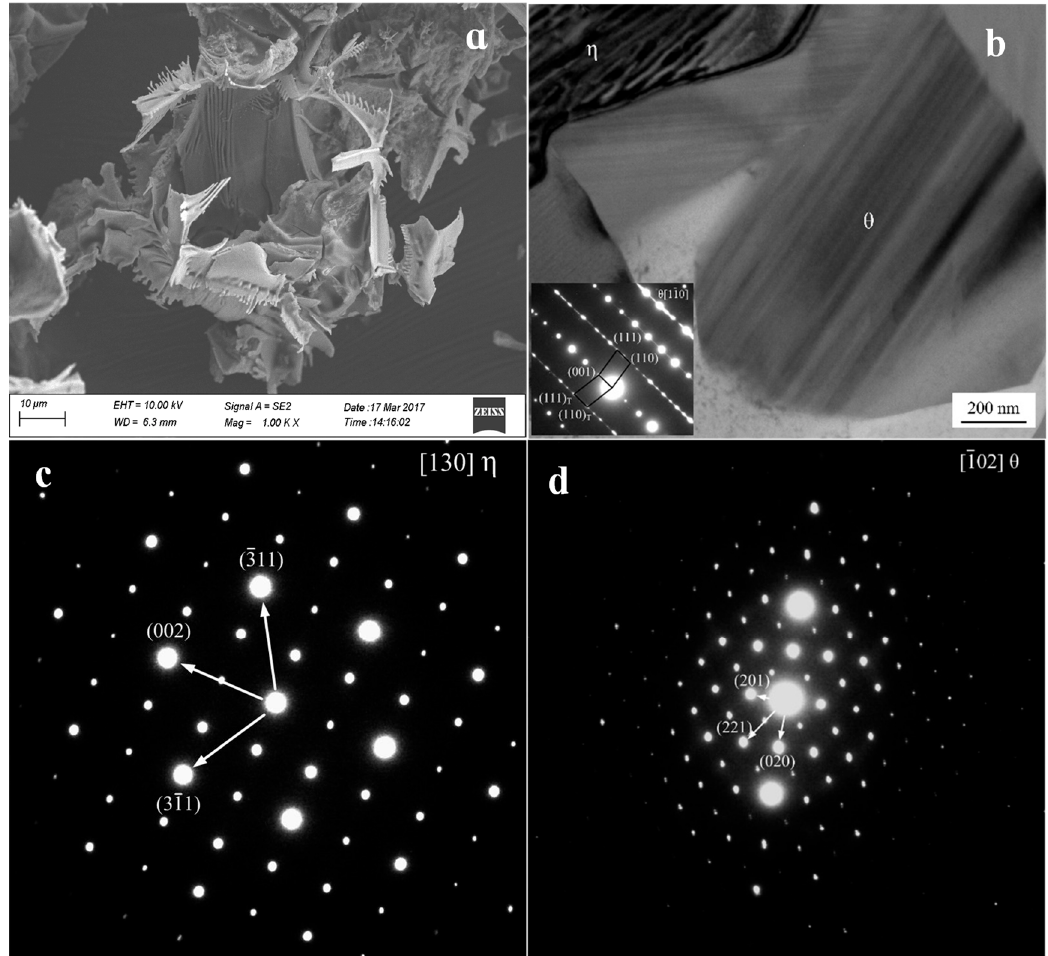
Figure 3. SEM image of the second-phase ( a ) and partial enlargement map ( b ) selected area electron diffraction (SAED) pattern of the Al 4 Er in [130] zone axis ( c ) and the Al 3 Fe in [1(cid:3364)02] zone axis ( d ).